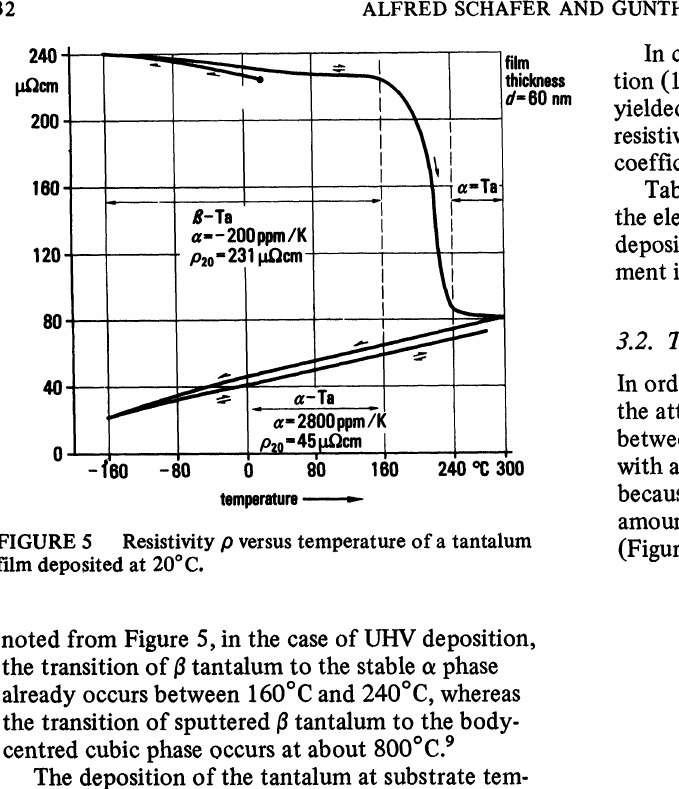
Phase diagram of tantalum-nickel